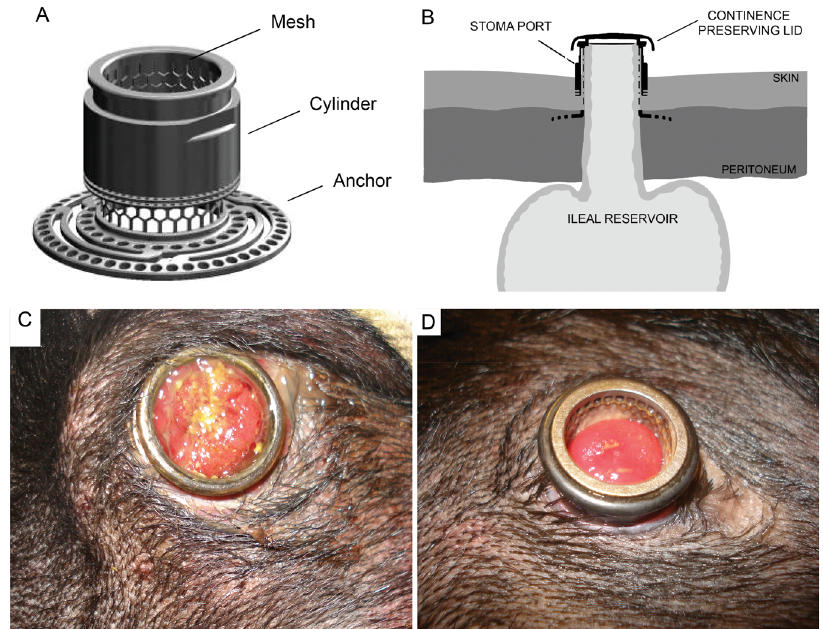
Fig. 1 A , B Con fi guration of the stoma port and surgical models used. A The stoma port consisted of a skin-penetrating cylinder with an outer diameter of 20 – 22.5 mm and a ring-shaped anchor measuring 33 – 35.5 mm in diameter. The perforation of the anchor ring allowed connective tissue ingrowth. A cylindrical titanium mesh (inner dia- meter, 15 – 17.5 mm; hexagonal openings, 1.5 mm wide; wire width, 0.3 – 0.46 mm) was enclosed by the cylinder and attached to the anchor. B The stoma model with the titanium stoma port installed in